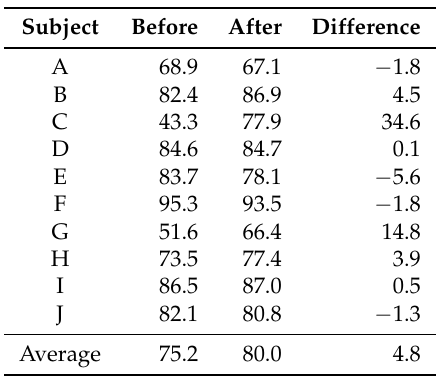
Table 9. Recognition accuracies before and after integration of learning datasets